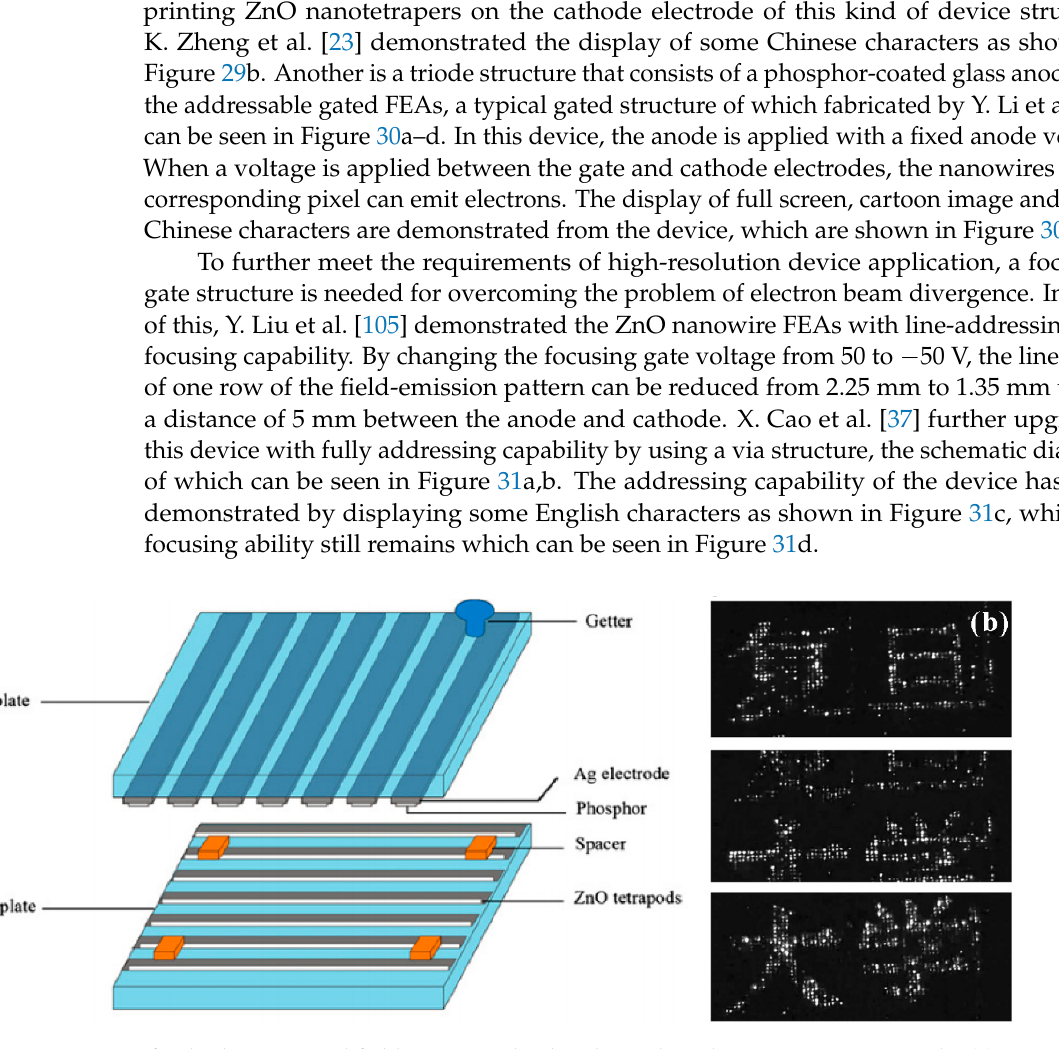
Figure 29. Demonstration of a diode structured field-emission display device based on ZnO nanotetrapods. ( a ) Device structure. ( b ) Some Chinese characters displayed by the device. Reproduced from [23], with the permission of Elsevier, 2008.